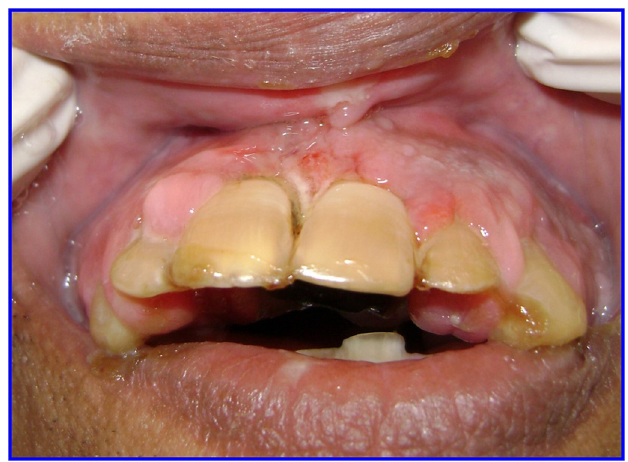
Fig. 4. Intraoral photograph seven days post removal of maggots.